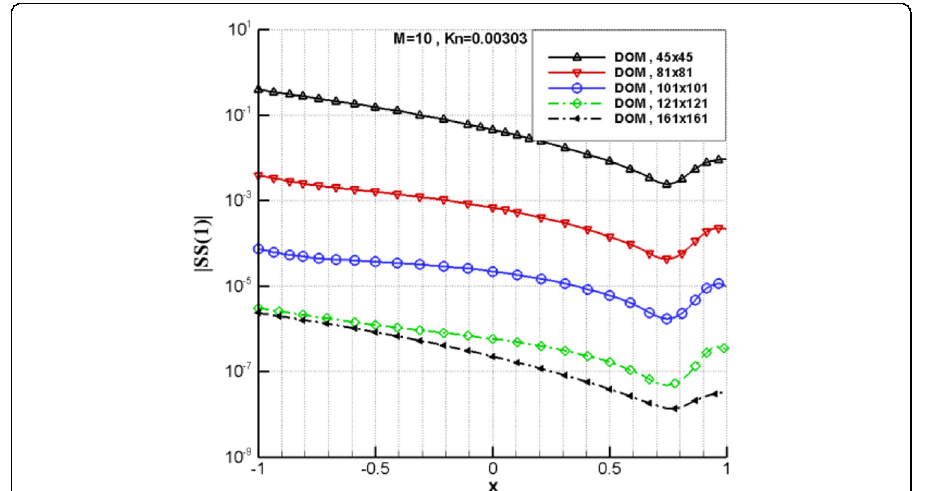
Fig. 8 |SS(1)| on the cylinder